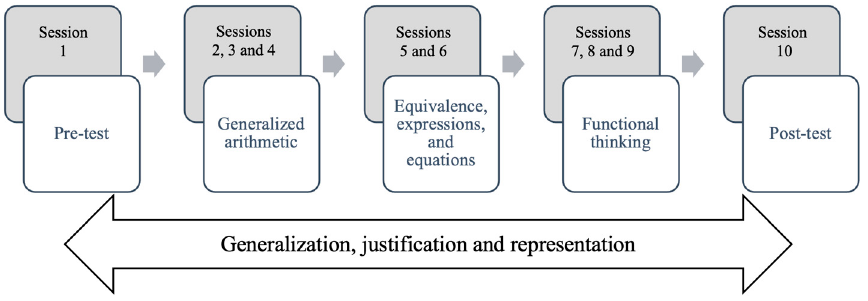
Figure 1. Organization of sessions.